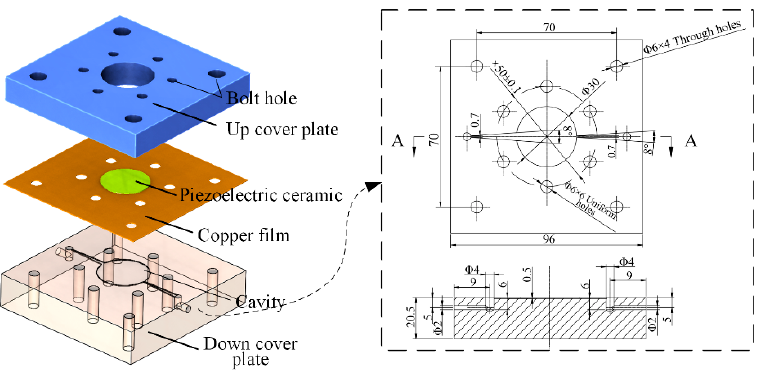
Figure 1. The structure of the designed valveless piezoelectric micropump.